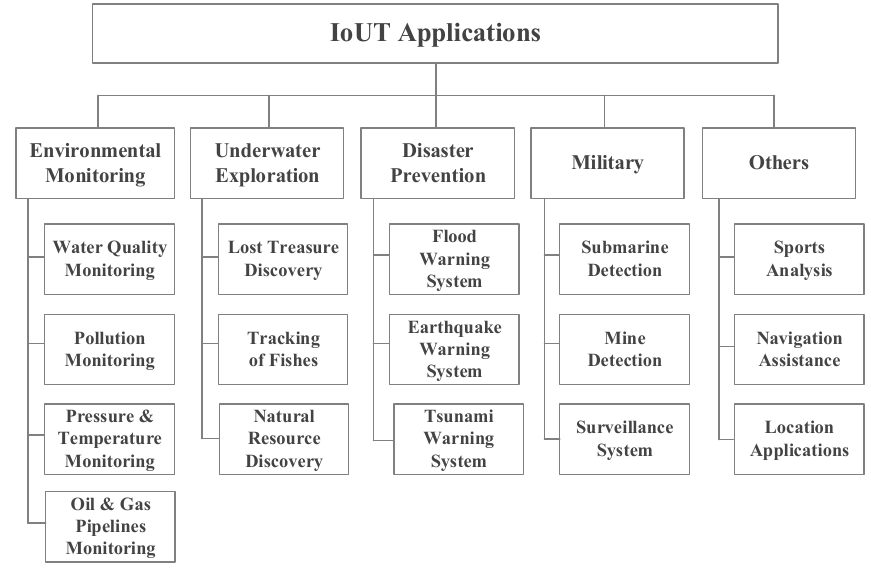
Figure 2. The IoUT applications.